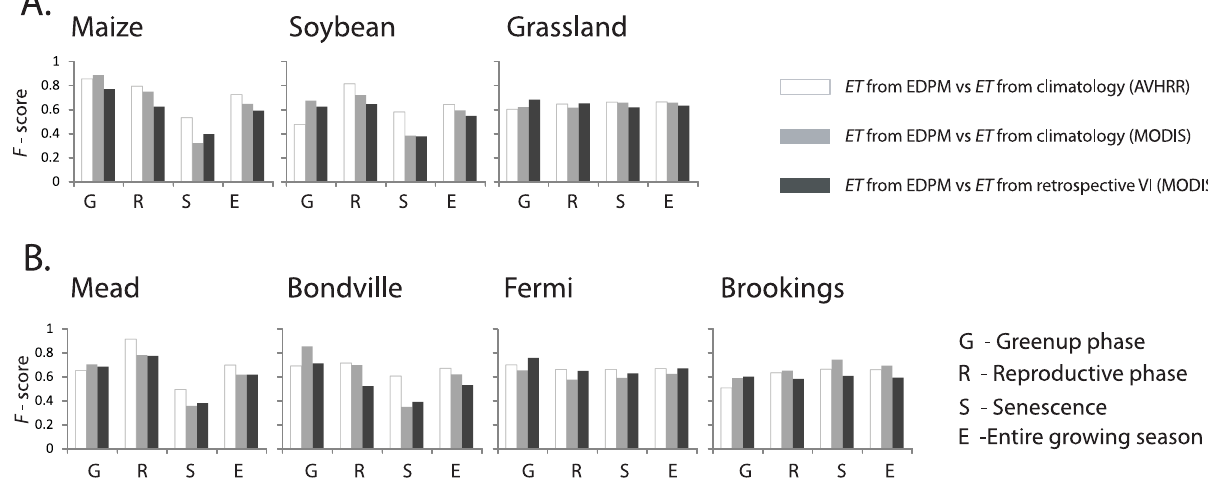
Fig. 6. Temporal details of VegET performance with different phenological forcings revealed by F -scores. Results arranged (A) by vegeta- tion/crop type and (B) by location.